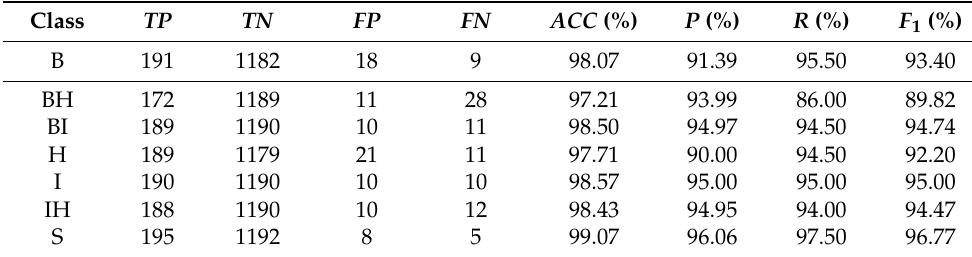
Table 4. Quantitative analysis results of the DenseNet_BC_34 model.